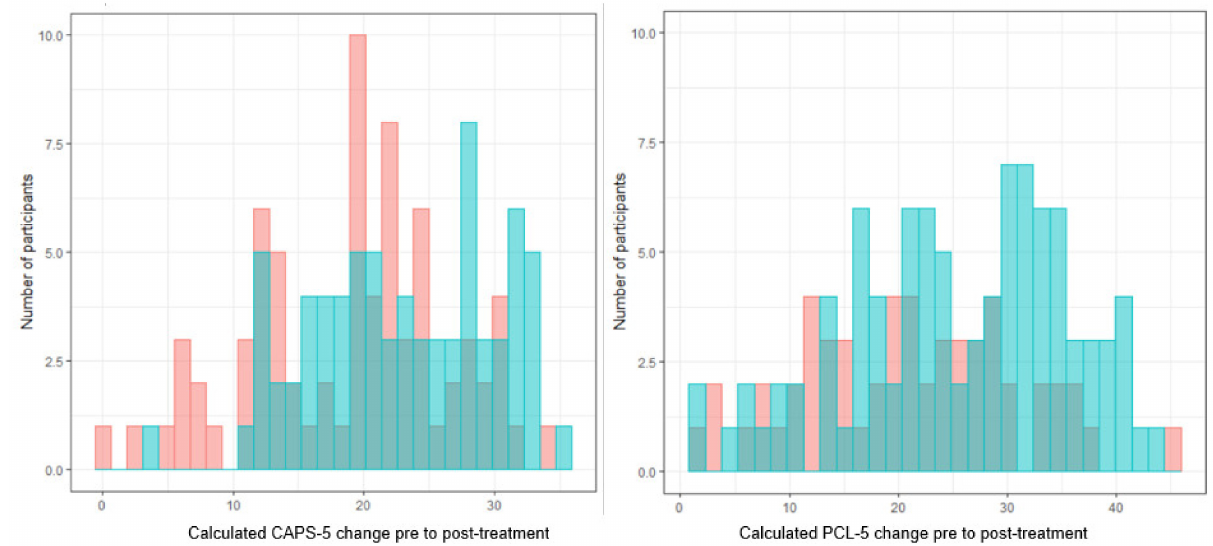
Figure 2. Calculated change in CAPS-5 ( left ) and PCL-5 ( right ) scores from baseline to posttreatment for patients randomized in their optimal (blue) and suboptimal (red) treatment